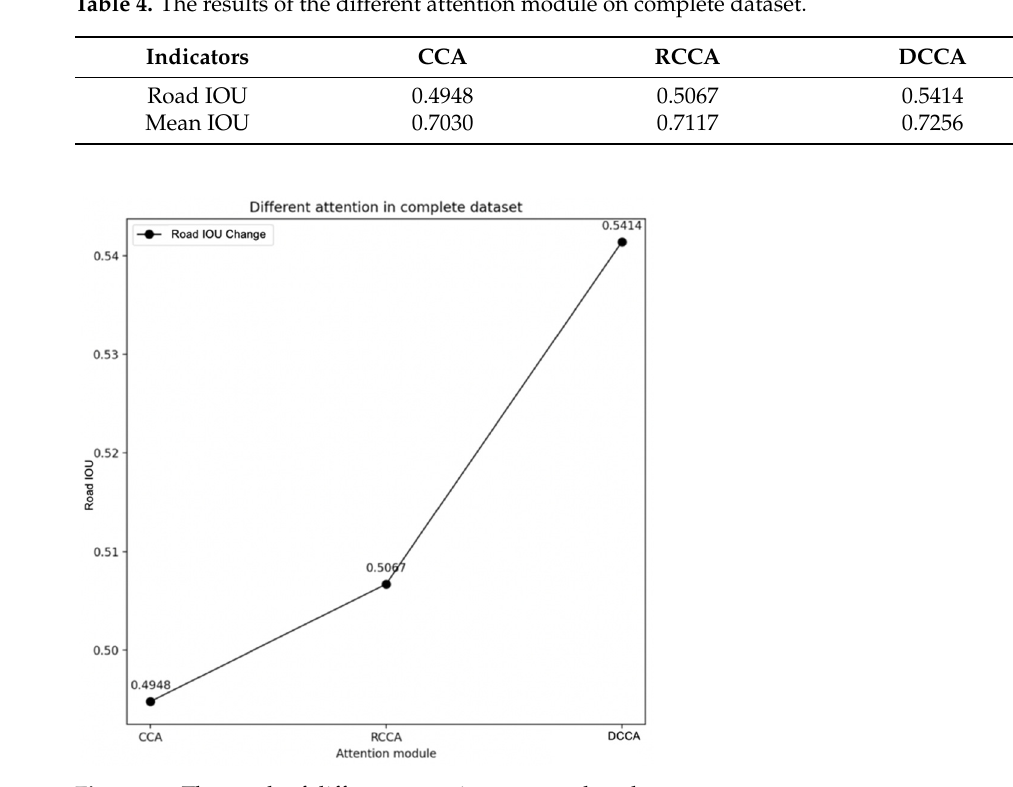
Figure 18. The result of different attention on complete dataset .